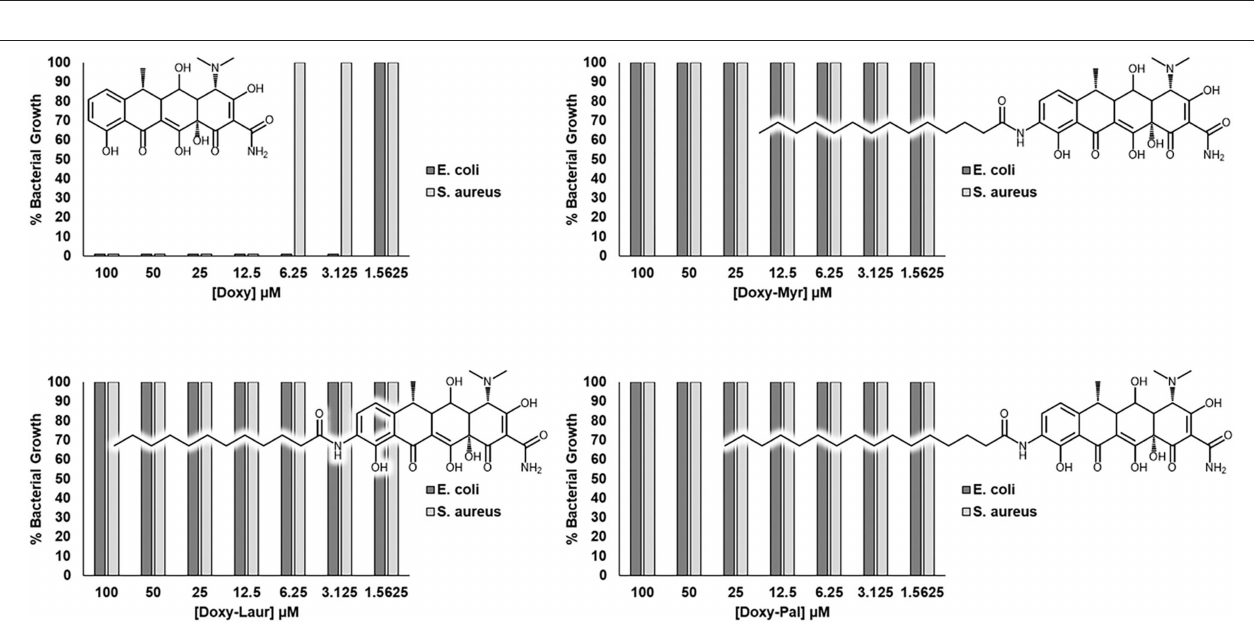
FIGURE 9 | Doxy-Myr, Doxy-Laur and Doxy-Pal do not show any residual antibiotic activity. The novel Doxycycline analogs (Doxy-Myr, Doxy-Laur, and Doxy-Pal) were screened against a gram-positive ( S. aureus ; ATCC 29213) and a gram-negative ( E. coli ; ATCC 25922) strain of bacteria to verify the maintenance of the antibiotic activity, when compared to the parent compound. While Doxycycline presented MIC values of 3.125 µ M against E. coli and 12.5 µ M against S. aureus , none of the Doxycycline analogs inhibited bacterial growth up to the concentration of 100 µ M.